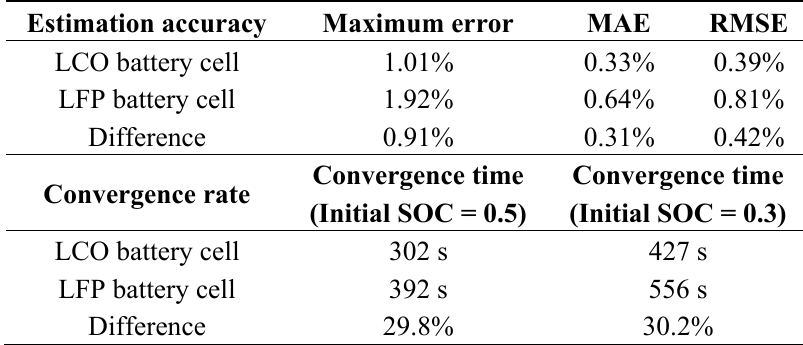
Figure 13. SOC-OCV curves for two cells: ( a ) Comparison of SOC-OCV; ( b ) Comparison of the derivation of SOC-OCV. Table 4. Comparison of LCO and LFP battery